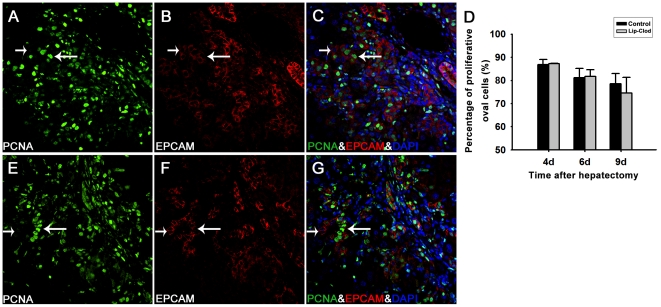
Oval cell proliferative activity as assessed by percentage of EPCAM positive cells labeled with PCNA.Double immunofluorescent staining for PCNA (green) and EPCAM (red) in the portal area was performed in liver sections from KC non-depleted (A–C) and depleted (E–G) 2-AAF/PH treated rats 6 days after PH (×400). PCNA positive (long arrow) and negative (short arrow) oval cells can be easily distinguished and counted. D: Percentage of proliferating oval cells was not significantly different between the two groups on days 4, 6, and 9 after PH. P>0.05. (Data represent mean ± SD, n = 3–4).